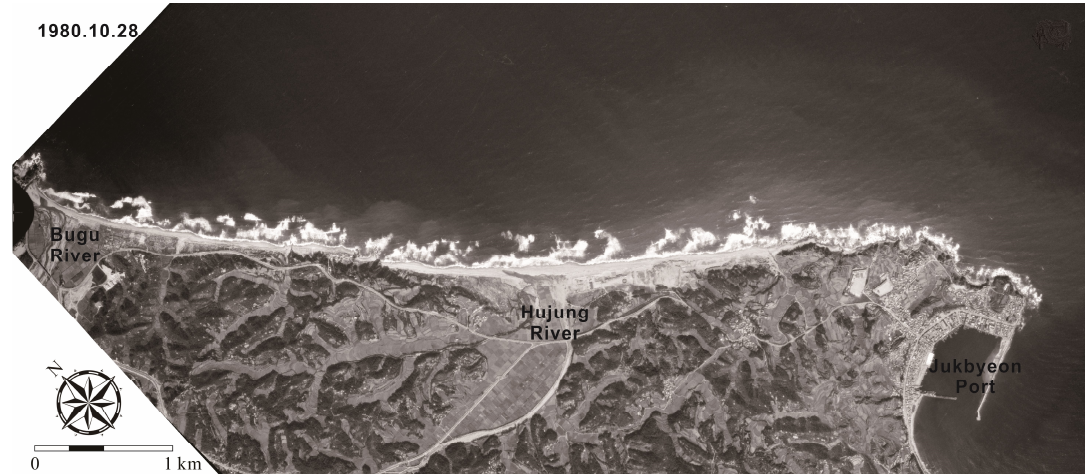
Figure 12. Aerial photograph over the Hujeong Beach area, taken on 28 October 1980 before the breakwater was constructed.